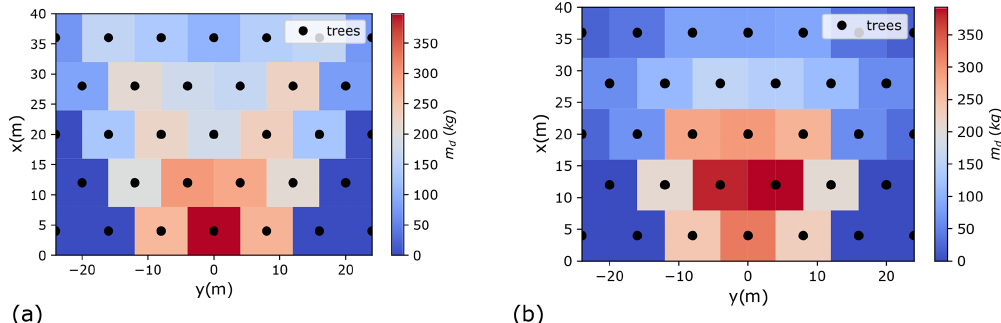
Figure 7. Distribution of the maximum detrainment mass behind each tree during the avalanche (regular staggered forest, d = 1m, e = 5 . 5m, snow properties: Case 2): (a) v 0 = 10ms − 1 ; (b) v 0 = 22ms − 1